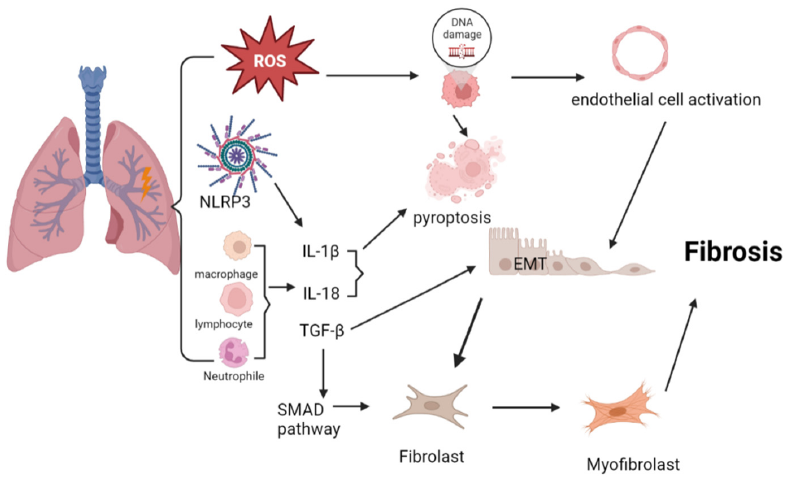
Figure 1. The mechanisms of RIPF: irradiation causes the generation of ROS, which results in DNA damage and activation of the endothelial cells. Inflammasome and immune systems are activated, thereby releasing IL ‐ 1 β and IL ‐ 18 and leading to pyroptosis. IL ‐ 1 β promotes the release of TGF ‐β , which triggers TGF— β /SMAD signaling pathway and induces EMT and fibrosis. (This figure was made with Biorender.).